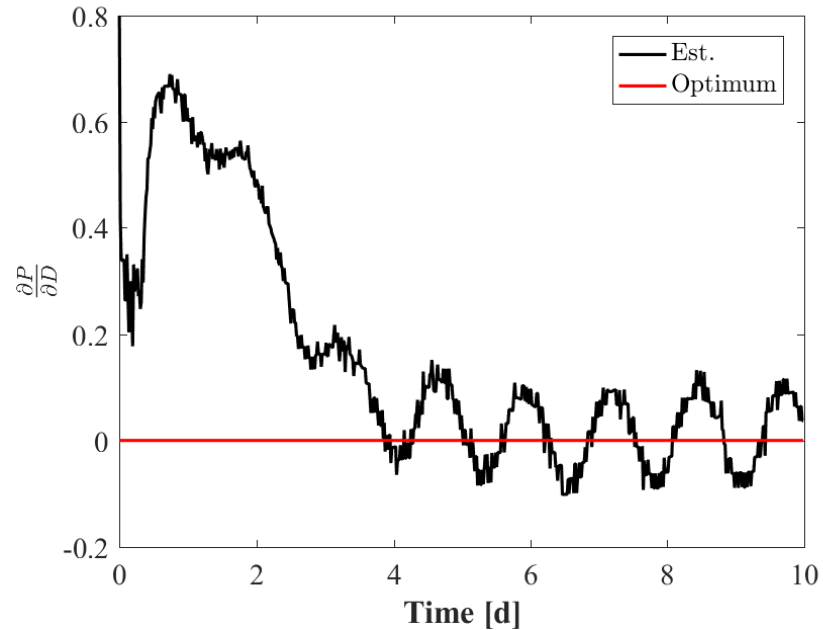
Figure 16. Experimental validation of RLS-ES on Dunaliella tertiolecta continuous cultures: gradient evolution - reproduced with permission (and slight modifications) from [102]